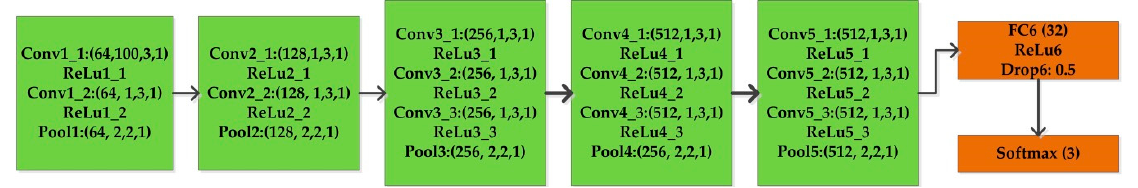
Figure 3. The architecture of the designed ship classification model based on VGG16.